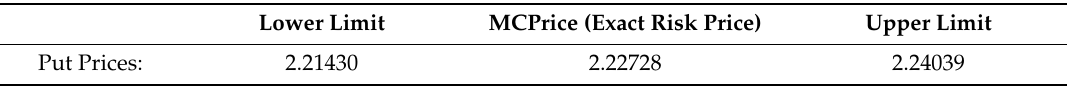
Table 3. Calculation of the exact risk prices for European options (time step =